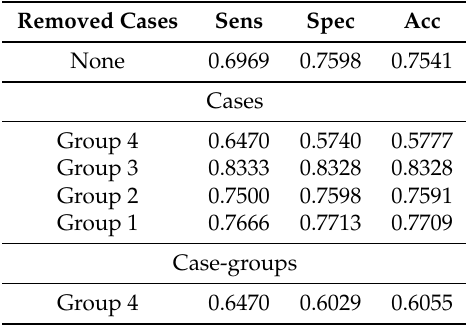
Table 5. Sens, Spec and Acc measures under global influence diagnostics for the asthma data.